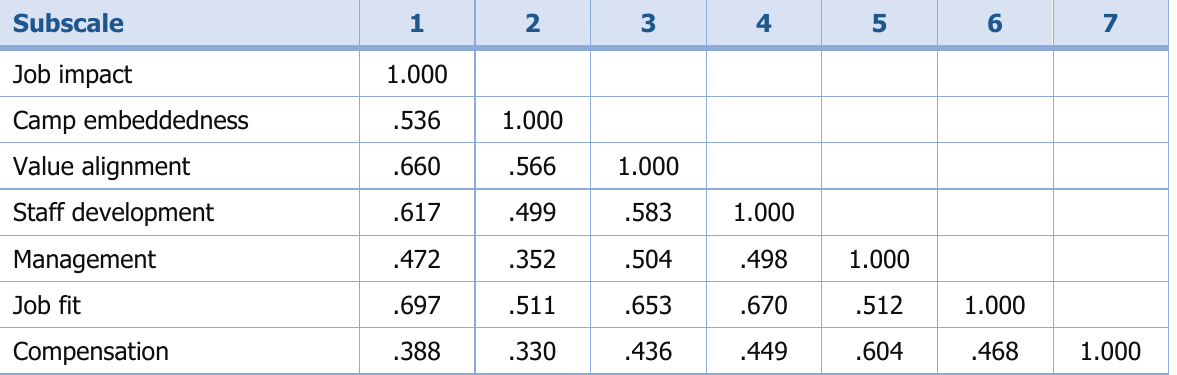
Table 4. Subscale Mean